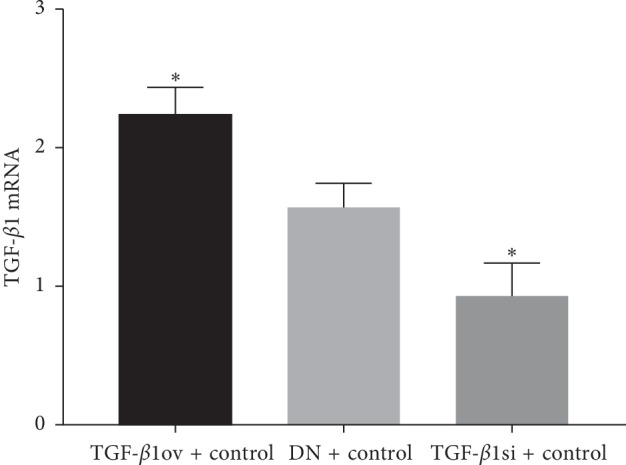
mRNA expression of TGF-β1. TGF-β1ov + control, TGF-β1 overexpression + oil; TGF-β1si + control, TGF-β1 siRNA + oil; DN + control, DN + oil. ∗p < 0.05 vs DN + control.